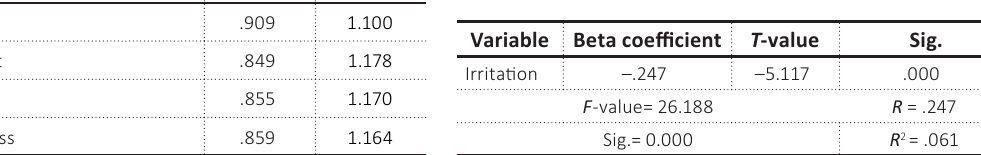
Table 11. Simple linear regression for testing